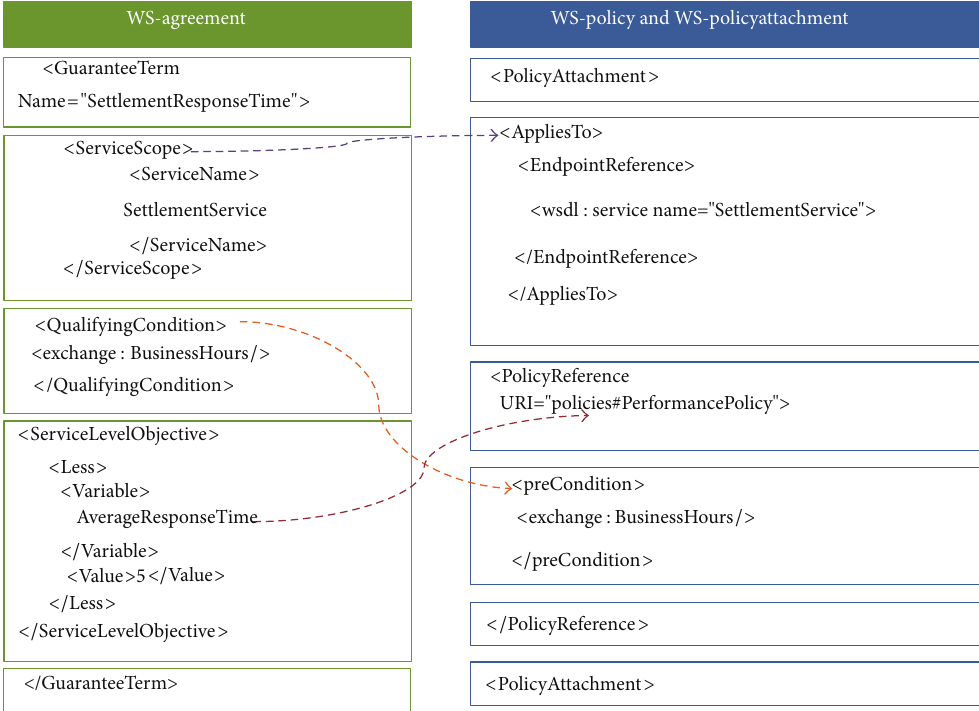
Figure 4: Integrating WS-agreement with orchestration-level